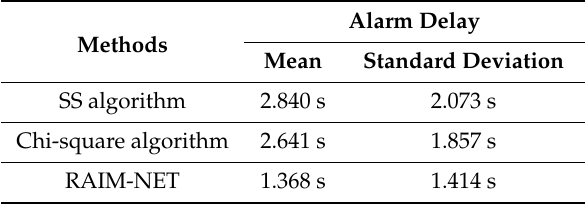
Table 3. Alarm delay of RAIM-NET and other methods for ramp